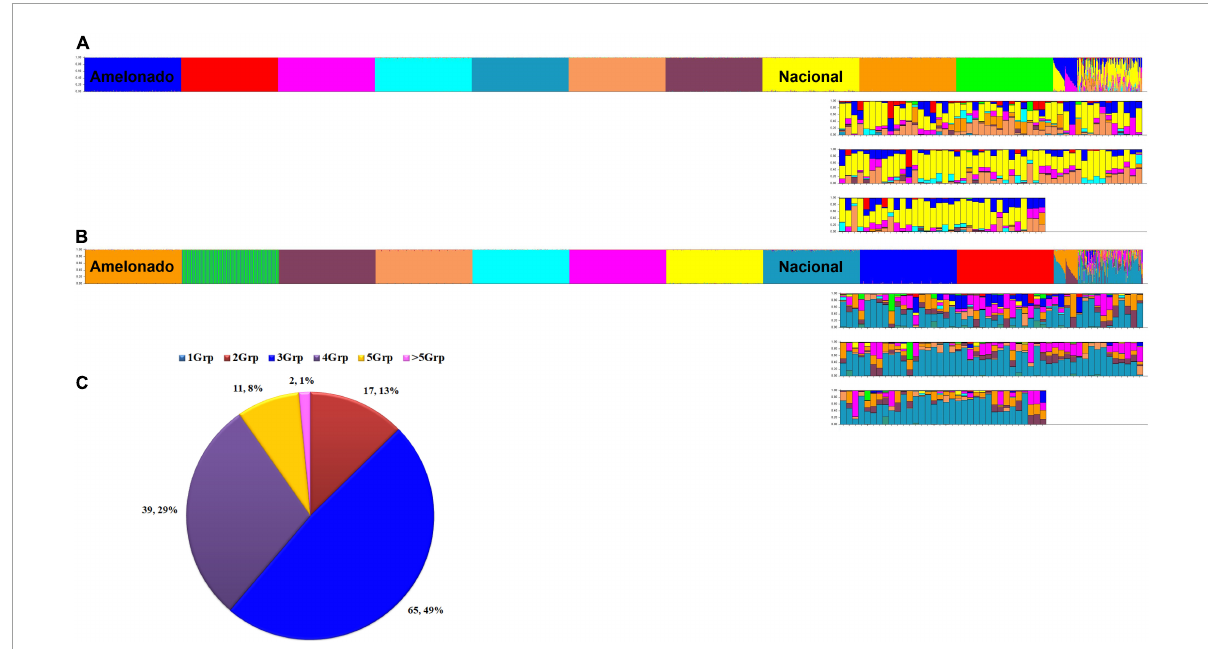
FIGURE5 Ancestry of 134 unique cacao samples (Peru Uniques) collected from northern Peru. Ancestry at K = 10 (A) and K = 11 (B) using 154 SNPs obtained from STRUCTURE (Pritchard et al., 2000) output using model based on 100,000 burnins, 200,000 Markov Chain Monte Carlo (MCMC) simulations, admixture ancestry model and independent allele frequencies. Samples are arranged as 10 reference populations (Amelonado, Contamana, Criollo, Curaray, Guiana, Iquitos, Marañon, Nacional, Nanay, Purús), Amelonado/Nacional, Amelonado/Criollo and Peru Uniques. Distribution of admixture classes (C) in Peru Uniques from 1 to more than five genetic groups (Grp) obtained from STRUCTURE (Pritchard et al., 2000) output using model based on 170 SNPs, 300,000 burnins, 600,000 MCMC simulations, admixture ancestry model and independent allele